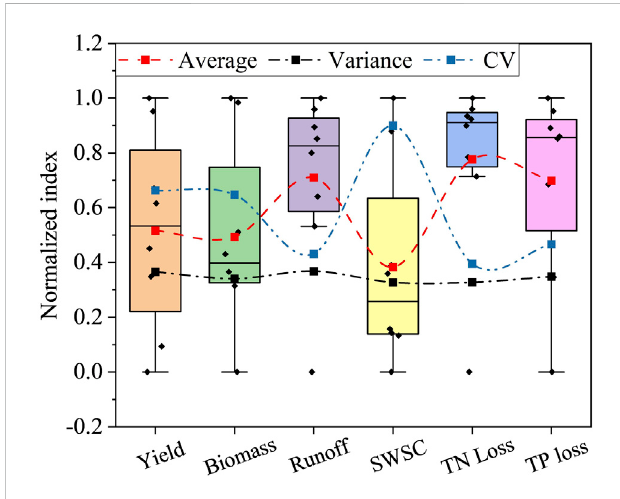
FIGURE 11 The distribution of the normalized